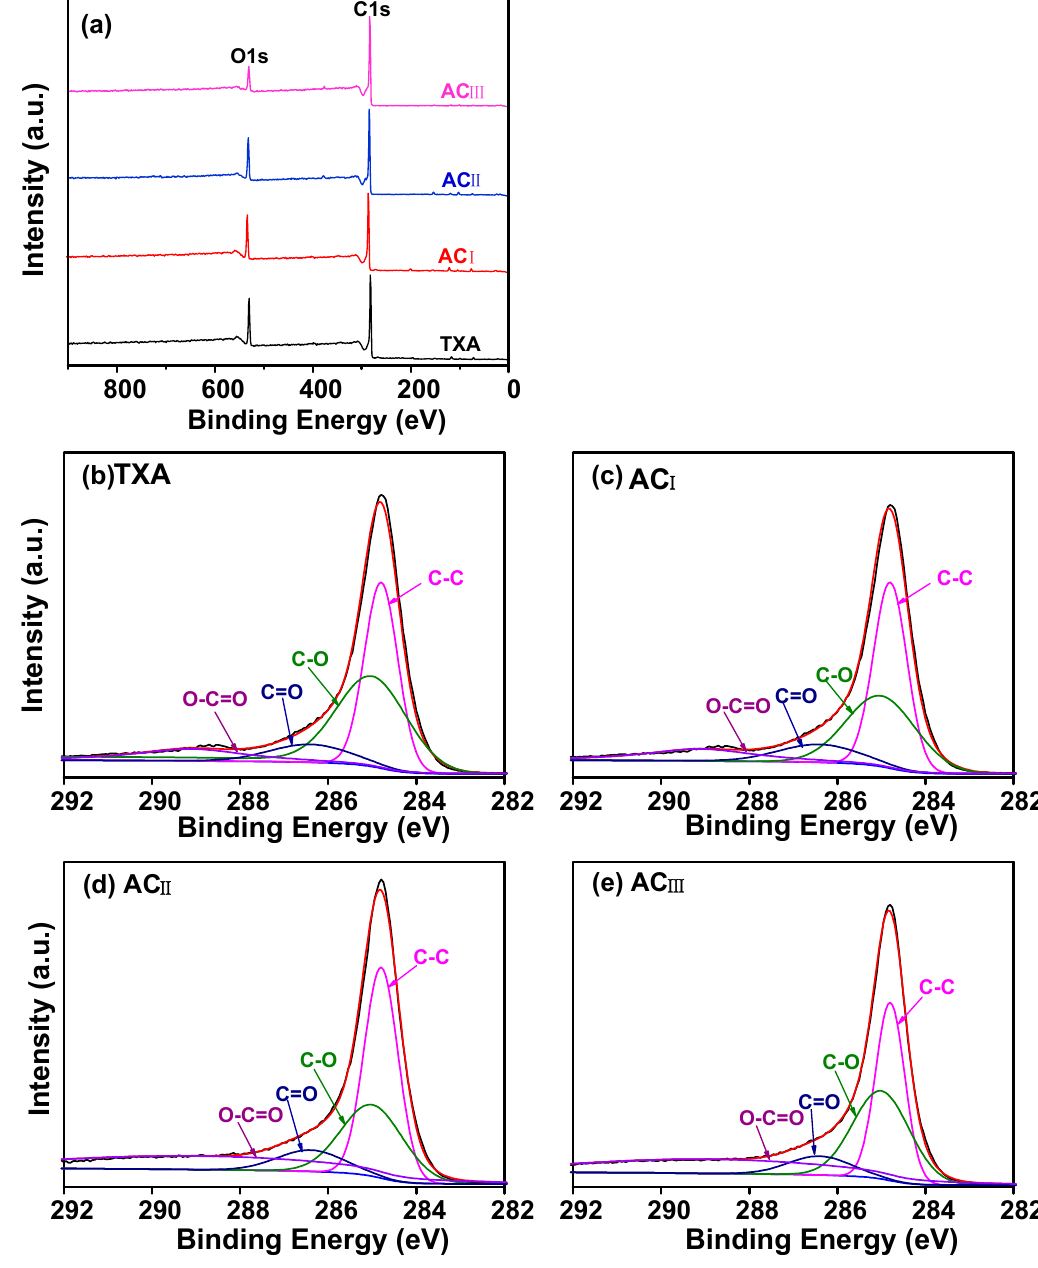
Figure 4. XPS survey spectra of ACs: ( a ) XPS wide scan spectra; ( b ), ( c ), ( d ) and ( e ) High resolution C1s